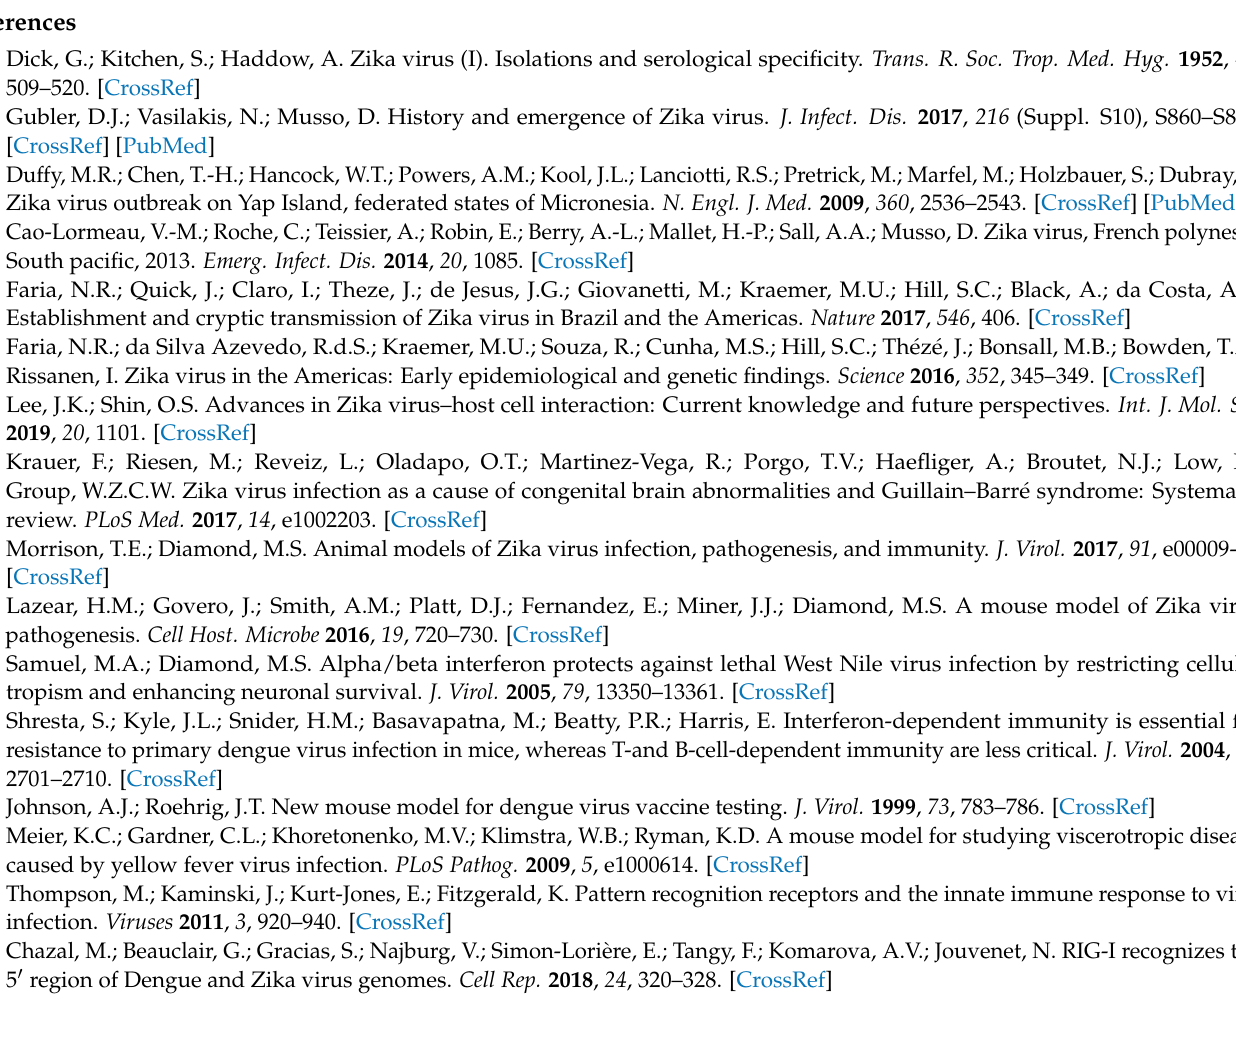
Figure S2: TRIM25 is not degraded during ZIKV infection; Table S1: List of primers used in this